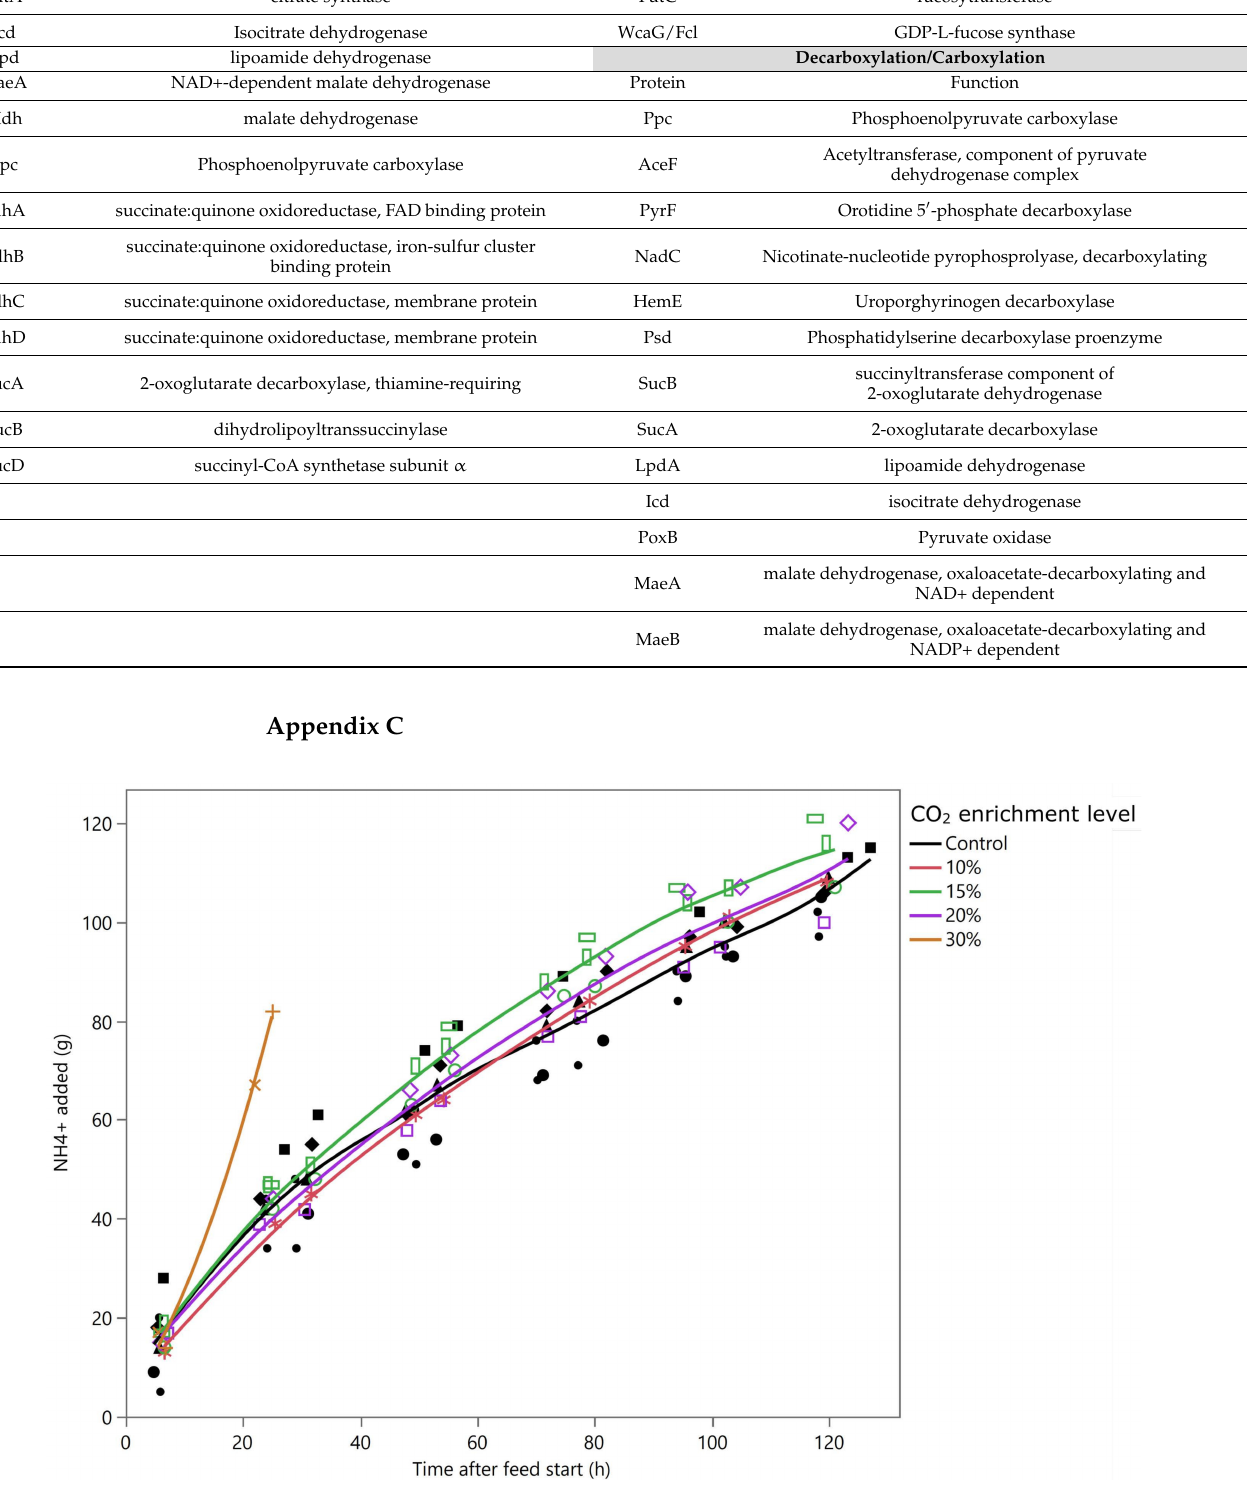
Figure A1. Ammonium (NH 4 + ) addition for C/N condition with different CO 2 enrichment levels for experiments with C/N limitation. The gravimetric NH 4 + addition was calculated from the base addition consisting of NH 4 OH. Each symbol represents a distinct